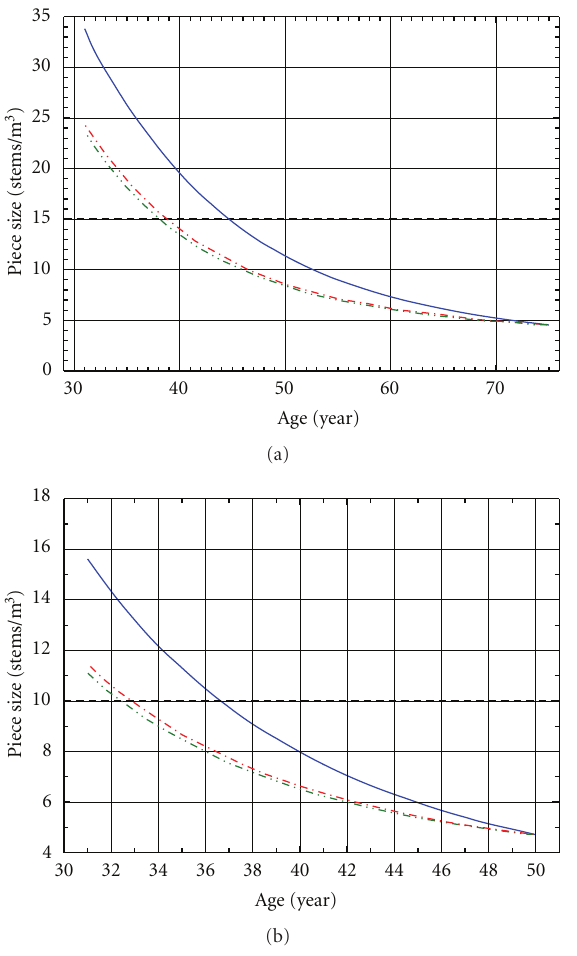
Figure 5: Type I response pattern as reflected in the merchantable volume-age relationship for poor-medium (a) and good-excellent (b) site qualities. Regime denotations are given in Figure 3. Note that the intersection of the horizontal dotted line denoting the specified operability criterion with a production curve indicates the earliest age at which the merchantable volume operability criterion is